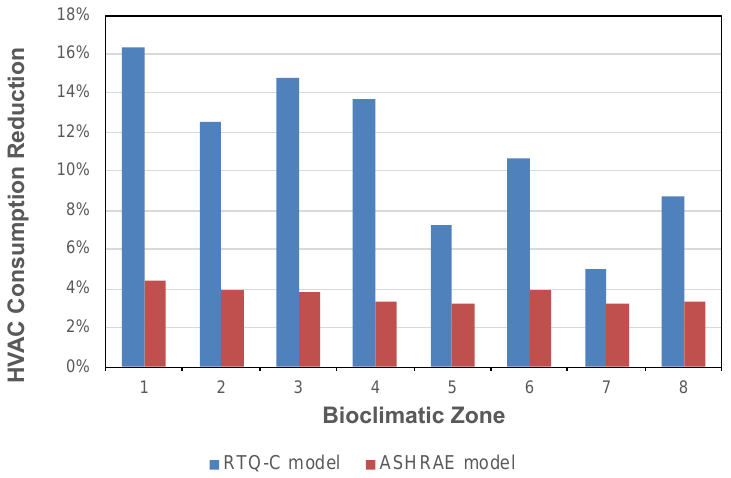
Figure 10. HVAC Reduction for T ctw /T as integrated optimization control.